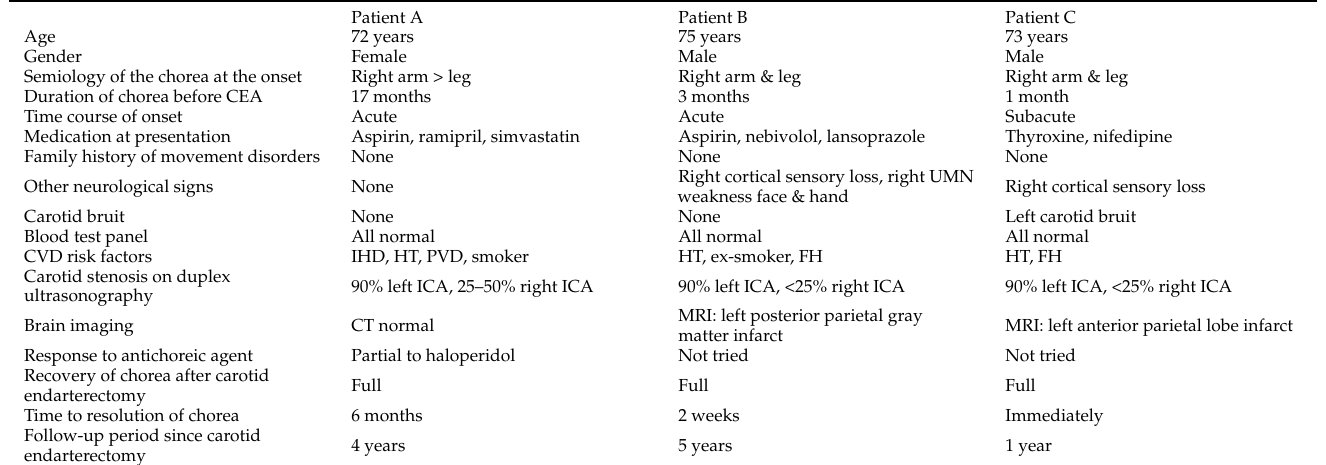
Table 1. Resolution of hemichorea following endarterectomy for severe carotid stenosis (2008)